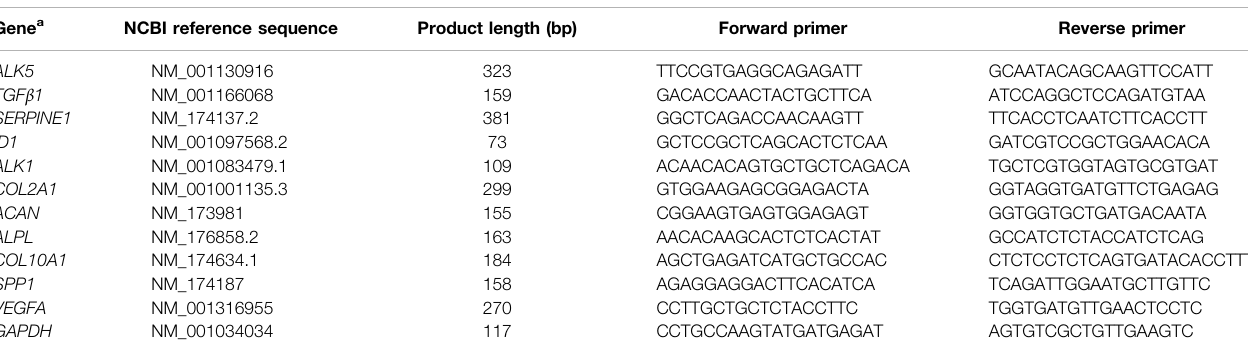
TABLE 1 | Sequences of the primers used in this